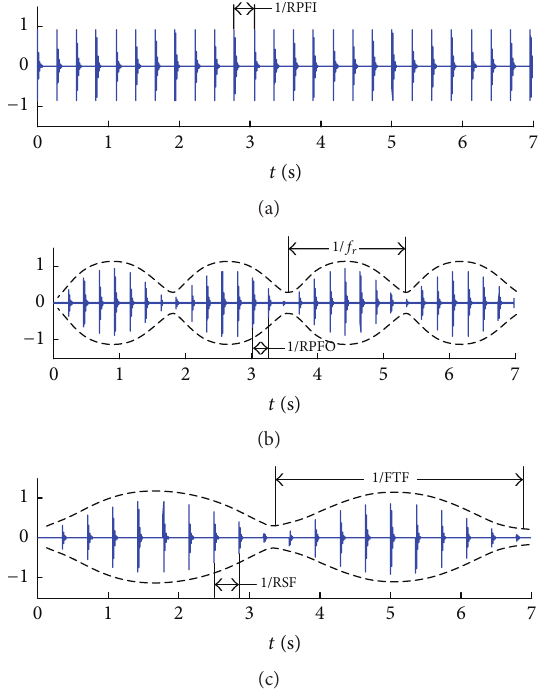
Figure 3: Bearing fault signals. (a) Inner race fault, (b) outer race fault, and (c) roller fault.